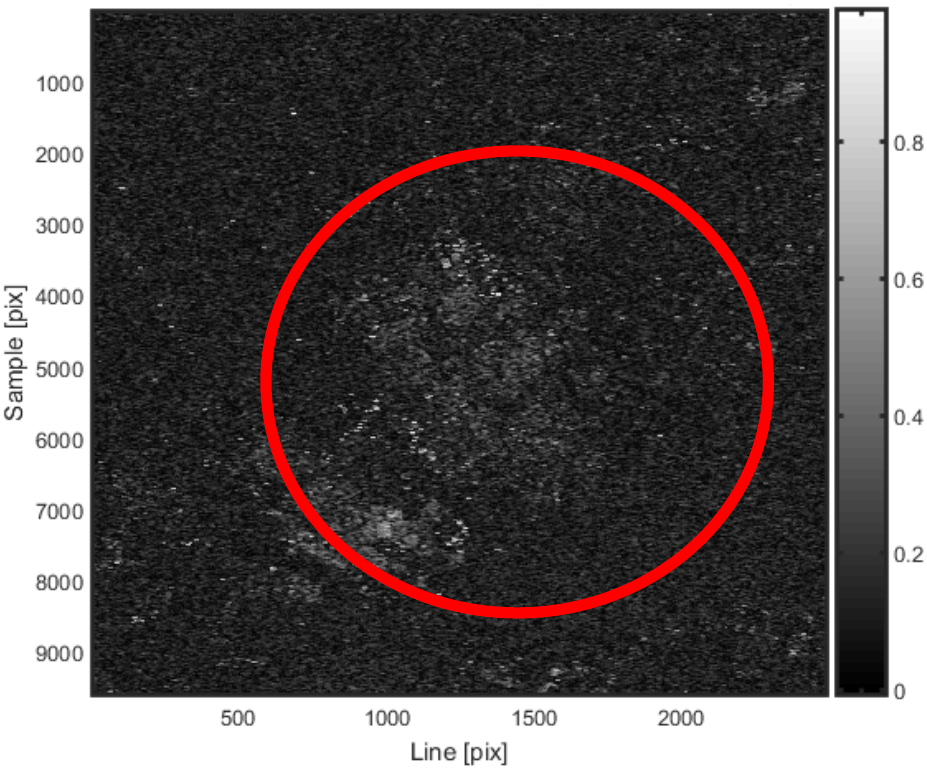
Figure 5. Coherence map showing persistent scatterer (built-up) features (in red circle). The LOS displacement, indicating the surface subsidence for 2017–18, 2018–19, 2019–20, 2020–21, 2021–22, and 2017–2022, is shown in Figure 6.